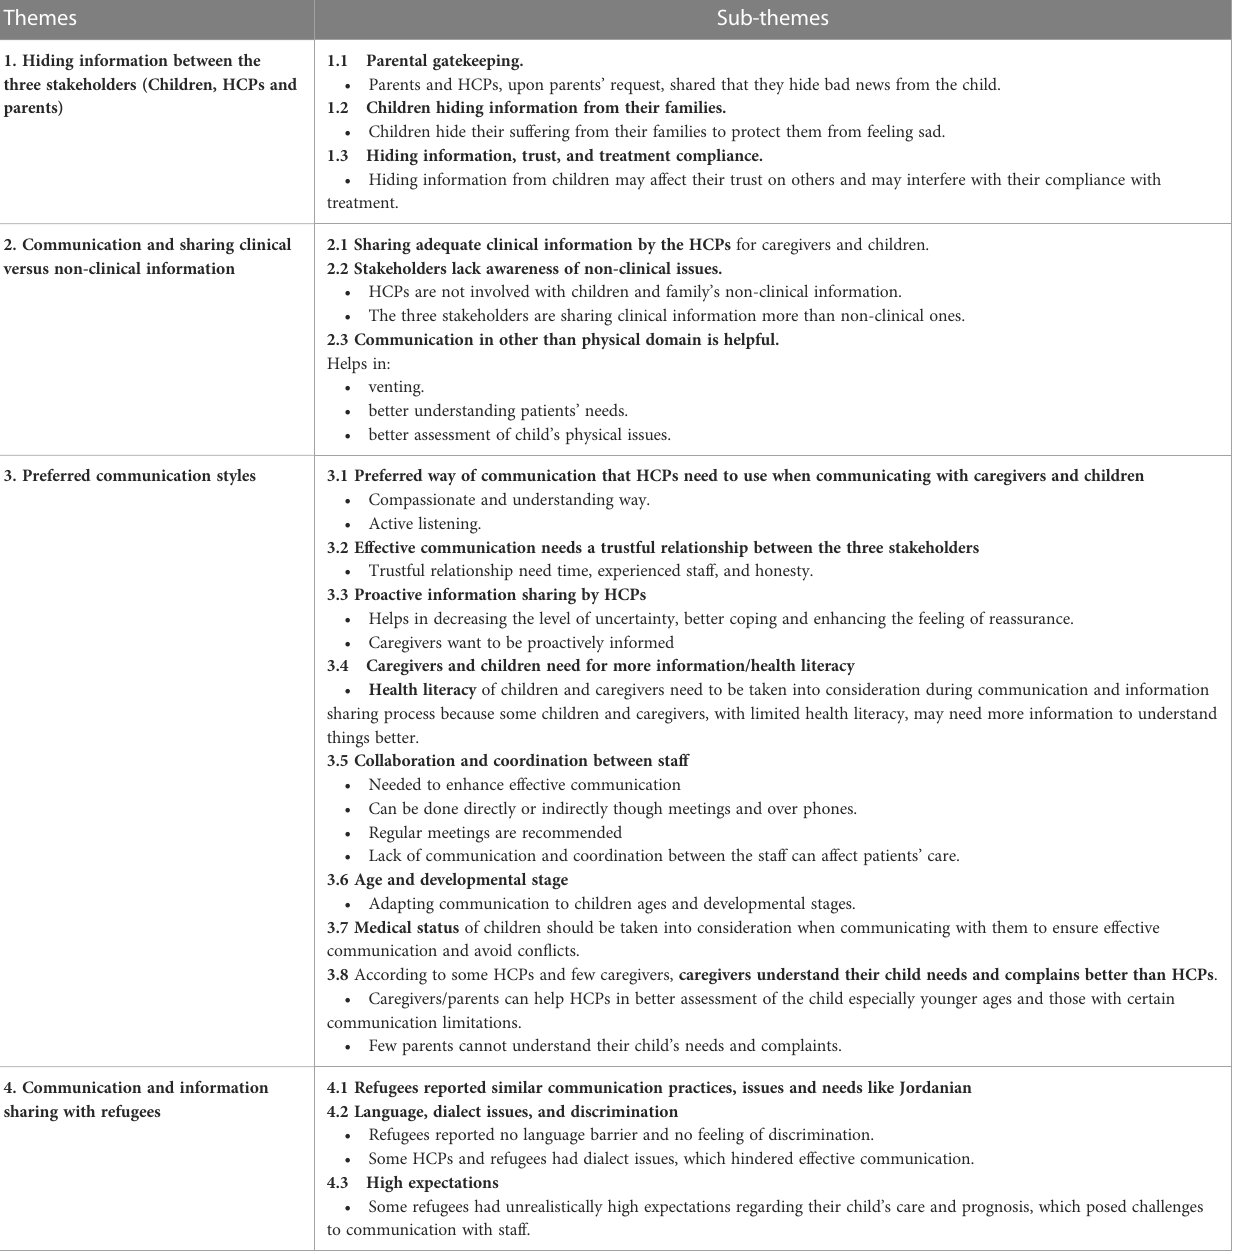
TABLE 3 Communication and information sharing themes and